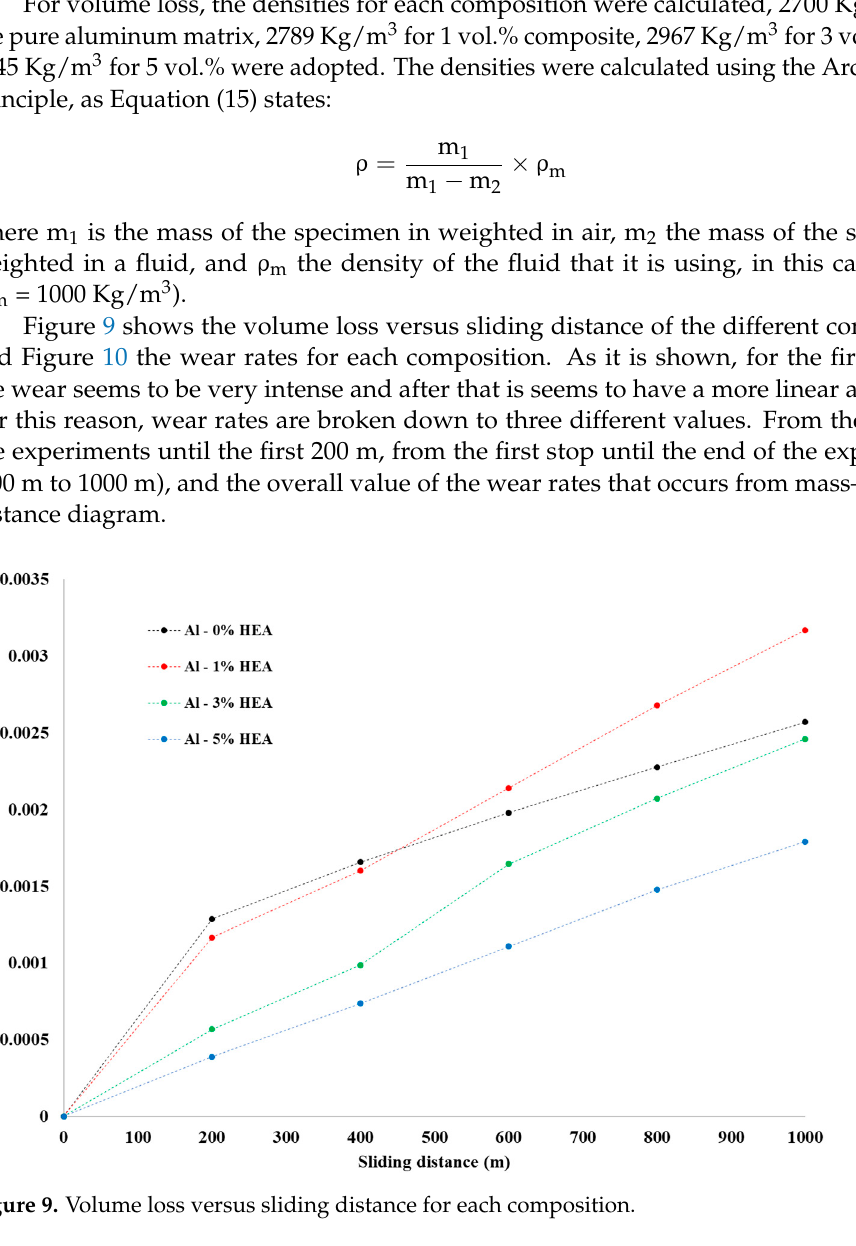
Figure 10. Wear rates for the initial 200 m, 200 to 1000 m and overall distance of each composition. The monolithic alloy and the composites do not follow the approach that with the addition of reinforcement the wear rates should be lower. This approach is observed in the three composites with a different percentage of reinforcement. The more the percent- age of the reinforcement, the better the wear response of the materials [40–46]. The beneficial act of the reinforcement particles in wear rate is: (a) the absorption of the load that transfers through the aluminum matrix delaying/blocking with that way the formation of cracks due to plastic deformation, (b) the reduction in the contact area be- tween the matrix and the counter body leading to delay to crack and defects due to exten- sive plastic deformation, and (c) to the provided thermal stability into the matrix (post- poning softening phenomena owing to heating) especially in severe wear conditions [20– 22].